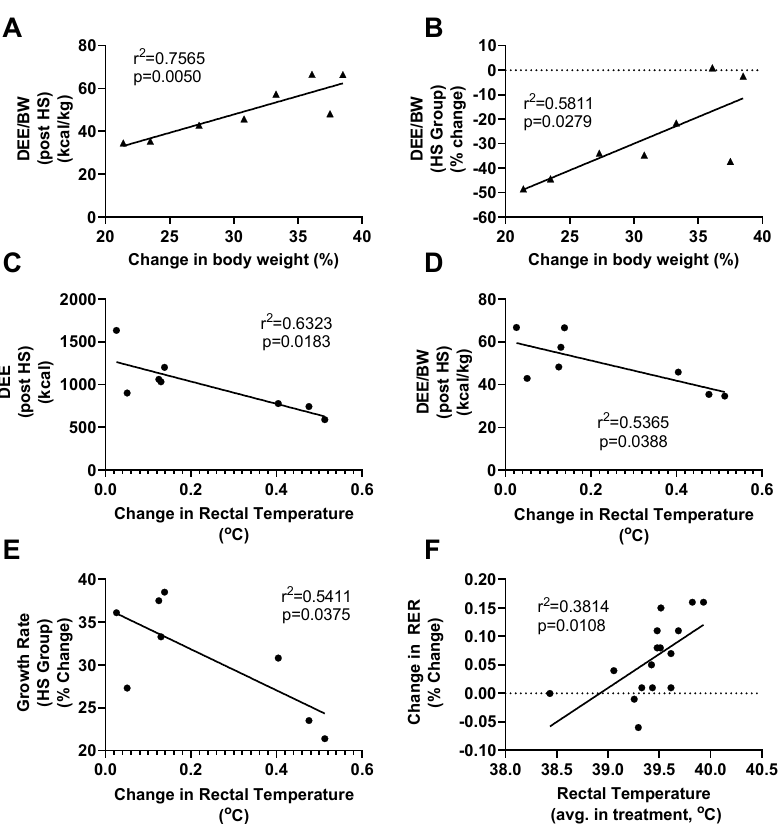
Figure 3. Relationship of daily energy expenditure (DEE) per bodyweight (BW) (post treatment, ( A ), and effect of treatment ( B ) compared to animal growth rates after 5 days of heat stress (HS)). Relationship of daily energy expenditure ( C ), daily energy expenditure per bodyweight ( D ) and growth rate ( E ) compared to change in rectal temperature during days after HS. Changes in RER after 5 days of HS or thermal neutral environmental treatments compared to average rectal temperature during treatment ( F ). Pigs were acclimated under thermoneutral conditions (14 h light/10 h dark, 21.6 ± 0.8 °C, with humidity 46–64%) for five days prior to treatment. Pigs were then randomly assigned ( n = 8 per group) to thermal neutral (TN, 22.0 ± 0.4 °C, with humidity 43-63%) or heat stress (HS, 33.6 ± 0.5 °C, with humidity 22-40%) treatment groups for five days.